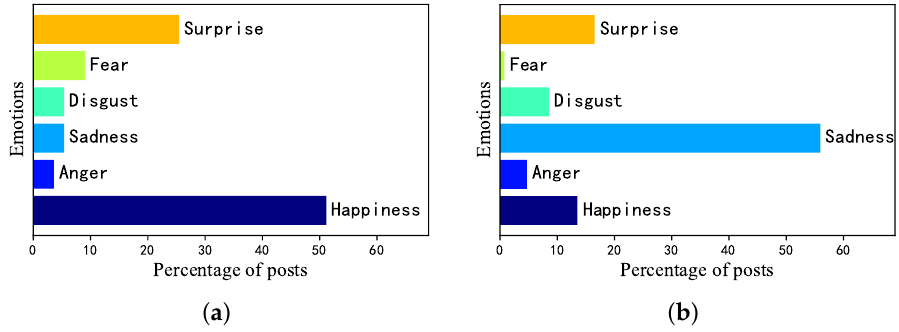
Figure 7. Percent of per emotion category on two datasets. ( a ) Twitter; ( b )